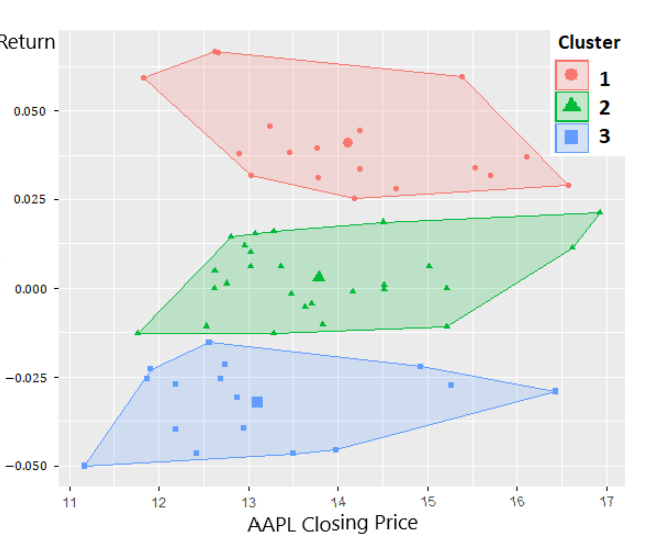
Figure 2. A snapshot of three-means clustering by using AAPL daily returns from 12 January 2019 to 7 April 2019. The plot included the closing prices as the horizontal axis for a better view, although the clustering was performed only using the return, which was the vertical axis.